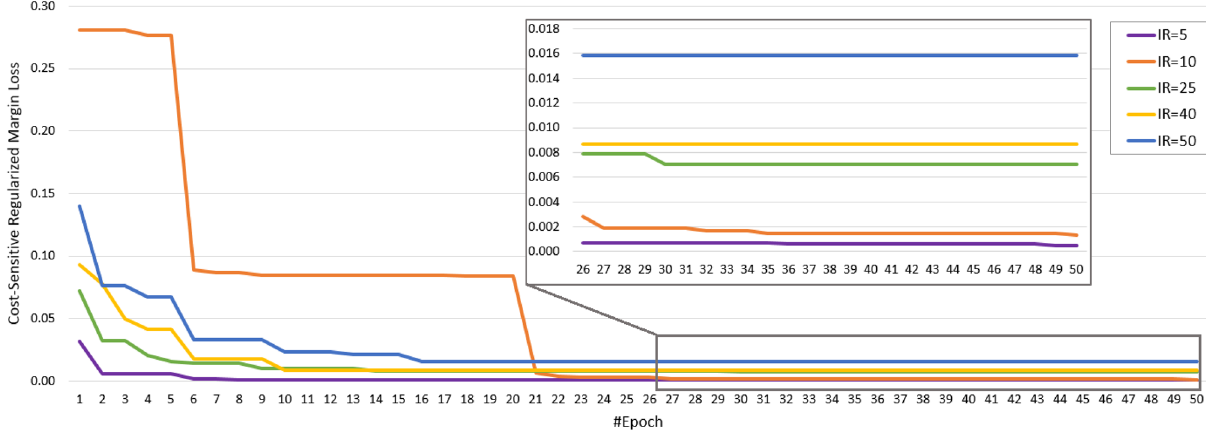
Figure 2. The Cost-sensitive regularized margin loss (error) of our RegCS.CapsDenseNet method with different imbalance ratios (IR) during the learning process on the HUST dataset.